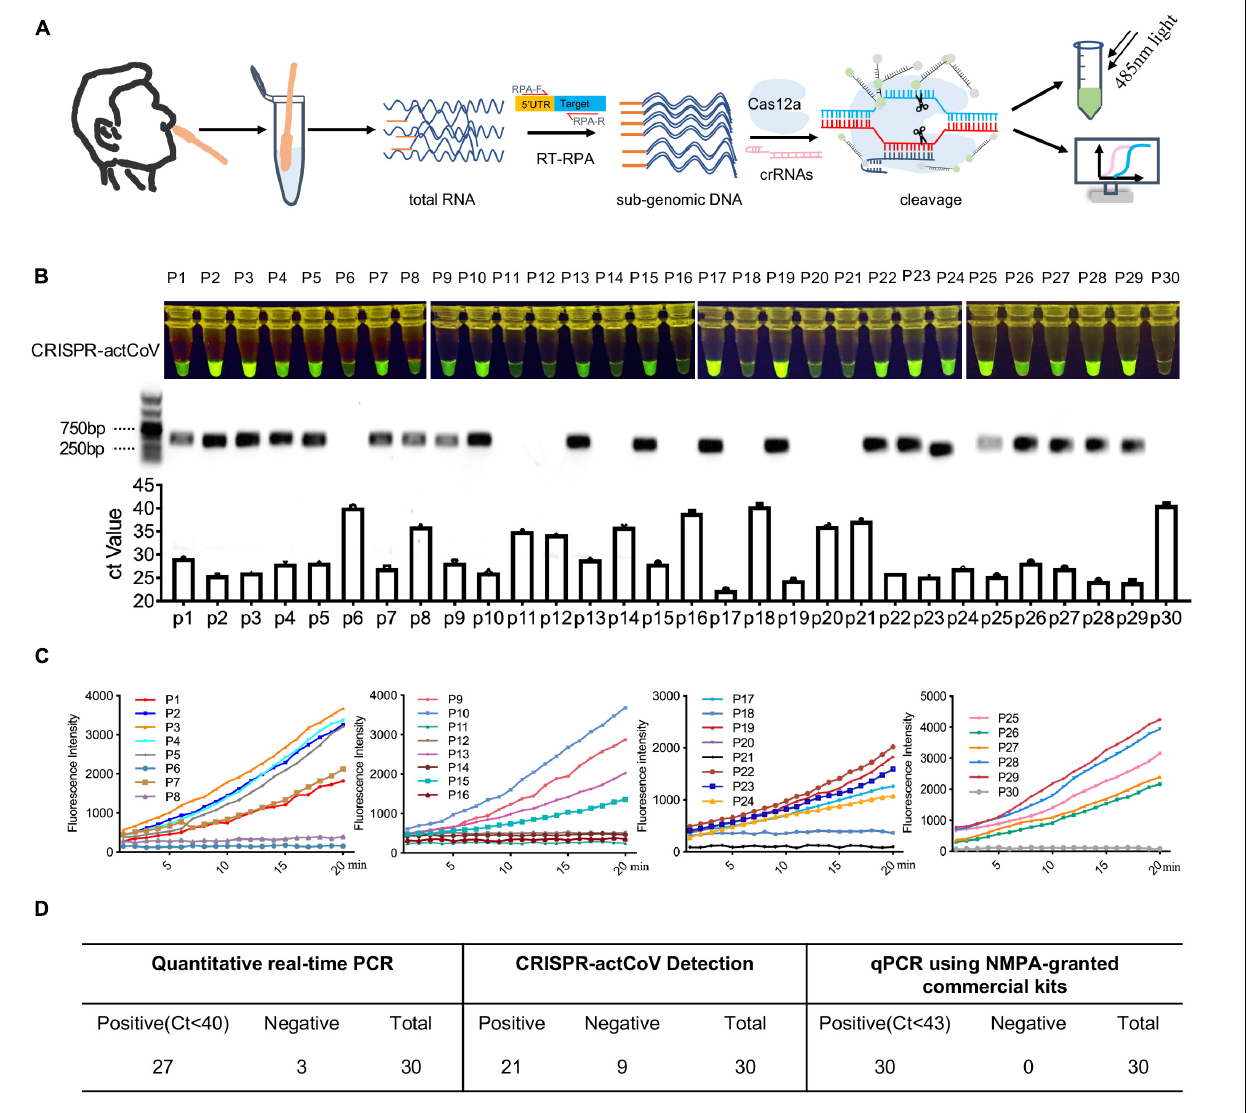
FIGURE 5 | CRISPR-actCoV mediated SARS-CoV-2 sgRNAs detection in clinical samples. (A) An illustration of the workflow of CRISPR-actCoV mediated SARS-CoV-2 sgRNAs detection in clinical samples. (B) SARS-CoV-2 detection in 30 clinical samples using CRISPR-actCoV (top panel), PCR of sgRNAs (middle panel), and qRT-PCR of gRNA (bottom panel). E gene was chosen as the detection target. (C) A time-course assay of SARS-CoV-2 sgRNA detection by CRISPR-actCoV in 30 clinical samples. (D) The results of CRISPR-actCoV detection in clinical samples compared with real-time